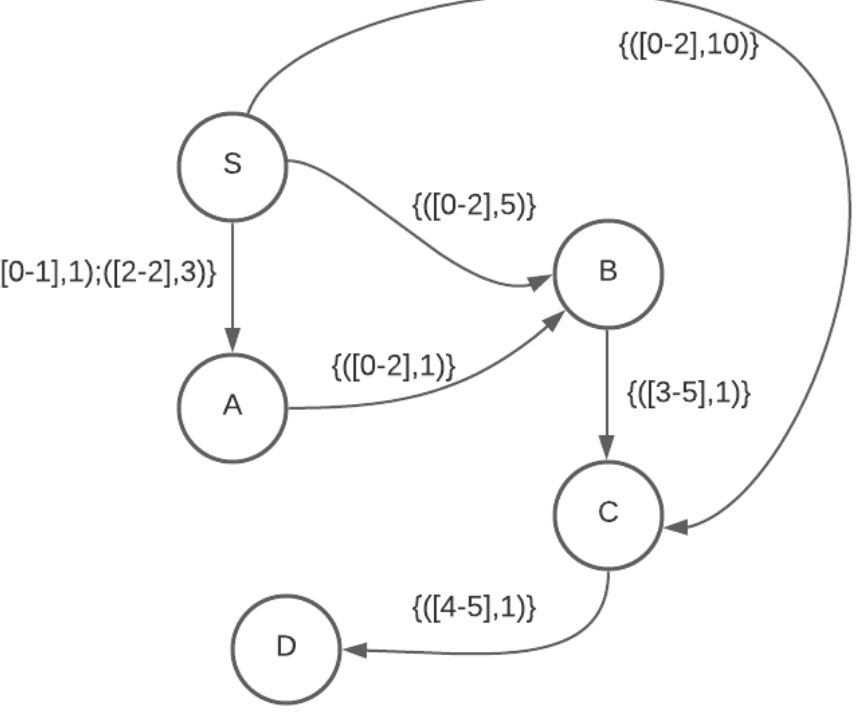
Figure 8. mhf paths in interval-temporal